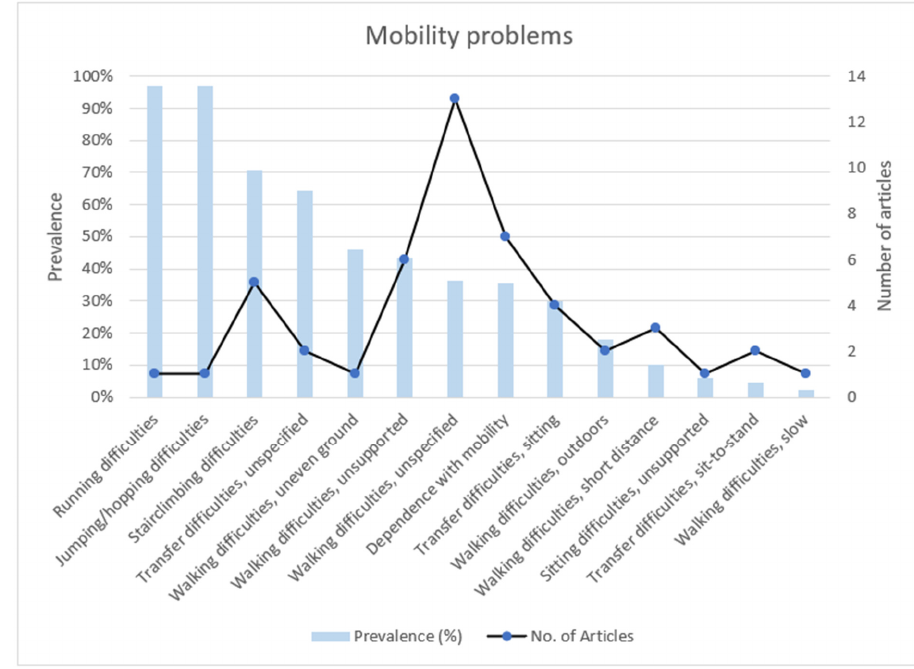
Figure 3. Prevalence and number of articles reporting on mobility problems.